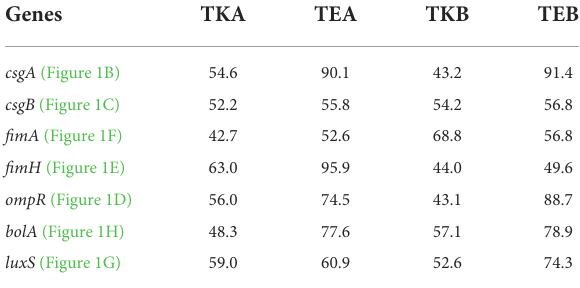
TABLE 1 Gene suppression level of different genes critical to the biofilm formation in E. coli in csgD-KD cells of E. coli Nissle 1917 and K12 strains (Note that TKA = K12 cell with mutation A, TEA = EcN cell with mutation A, TKB = K12 cell with mutation B, TKB = EcN cell with mutation